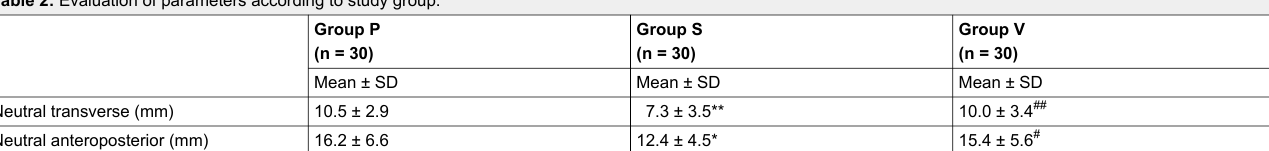
Table 2: Evaluation of parameters according to study group.